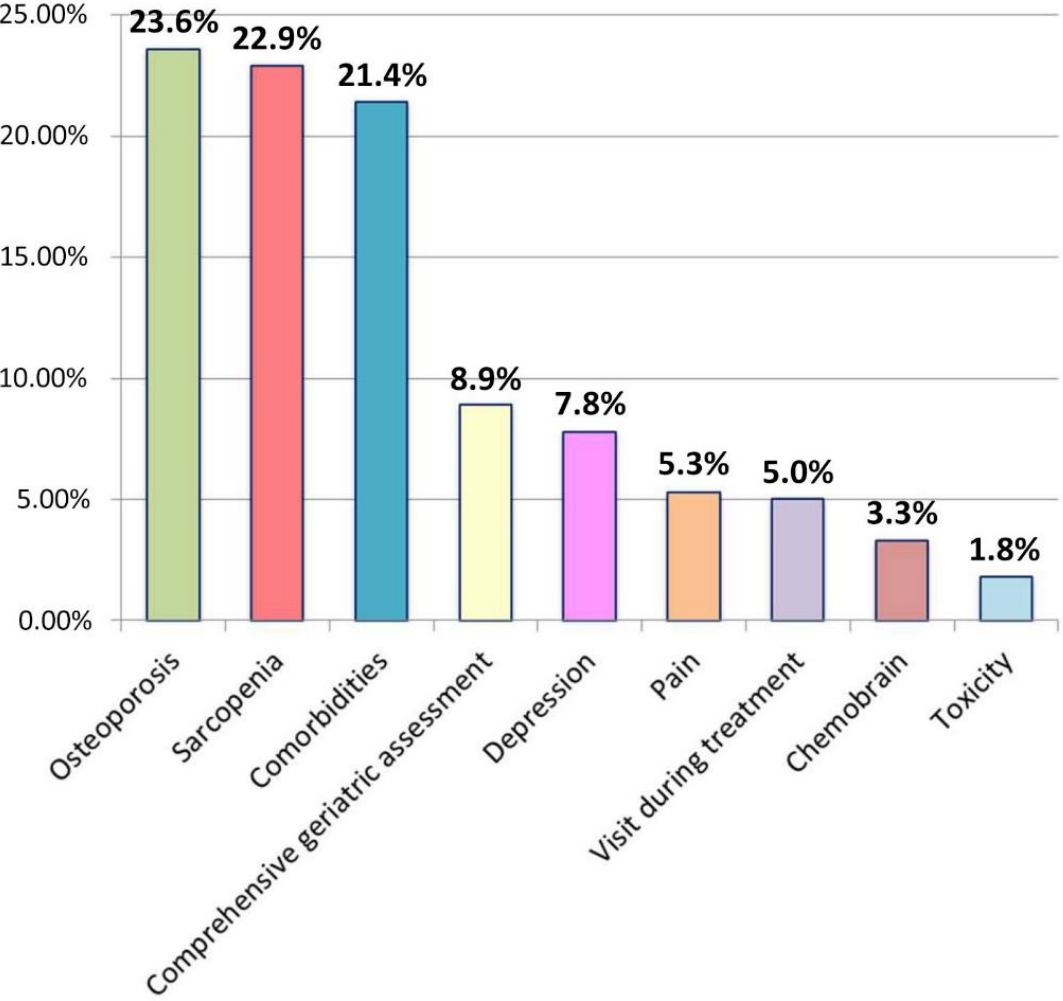
Figure 2. Reasons for outpatient evaluations .